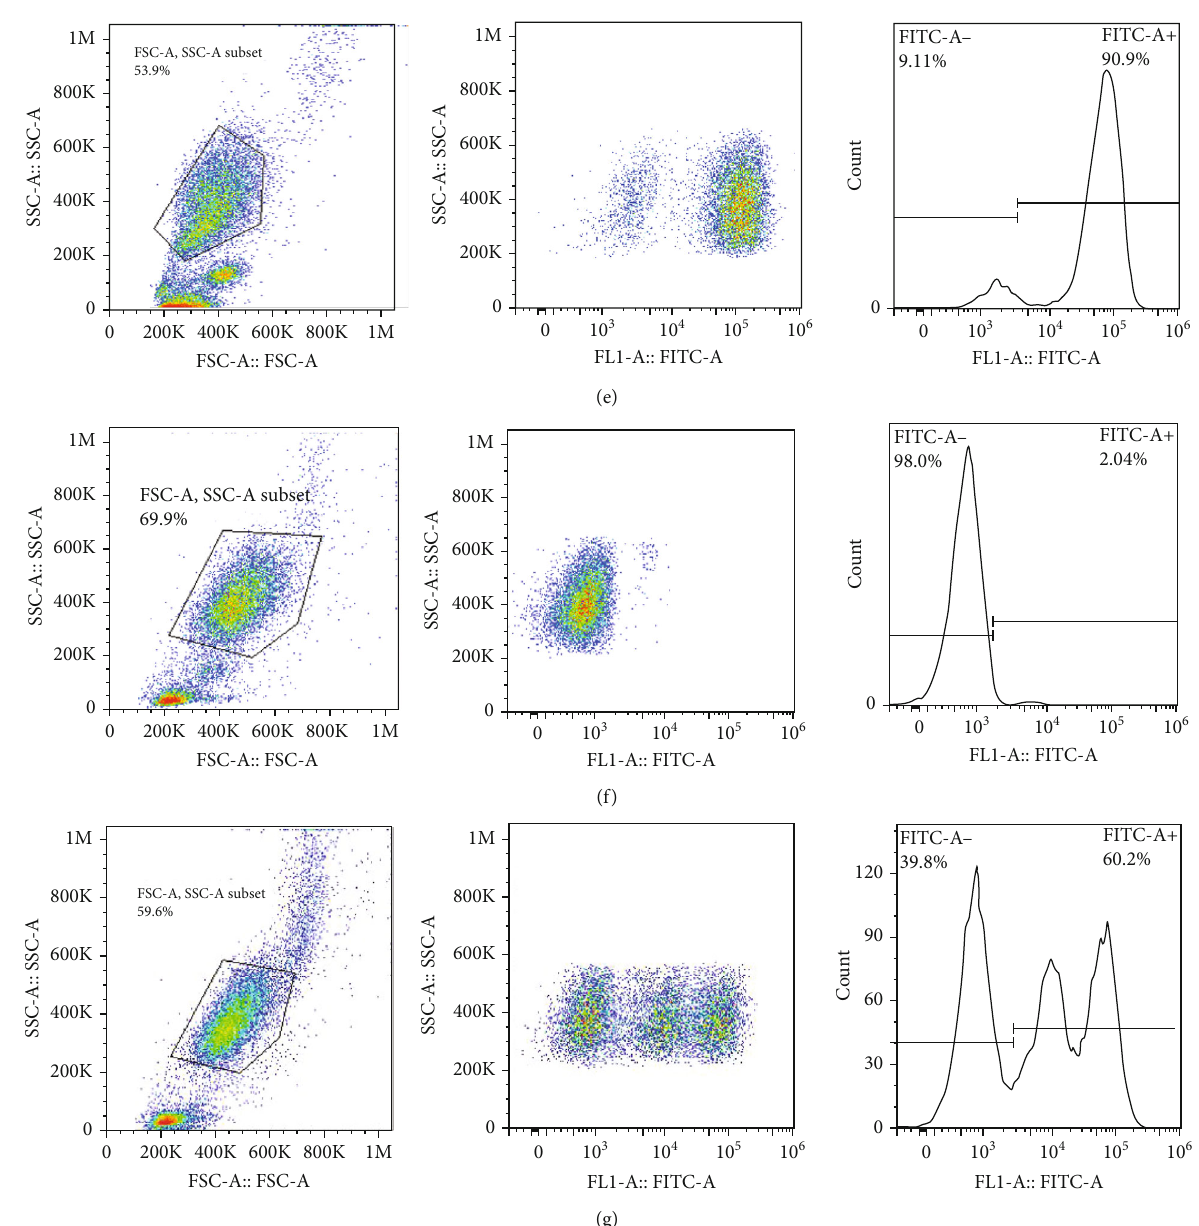
Figure 2: Flow cytometry analysis of HNA-2 expression on the neutrophils. The neutrophils were stained in whole blood with FITC conjugated anti-CD177 antibody. (a, b) Unstained and isotype controls were used to set up the fl ow cytometer and analyze the results. Based on HNA-2 expression, two distinct populations were identi fi ed. Among donors, the expression of the HNA-2 antigens was varied. For analysis, individuals were divided into four categories: (c) HNA-2 expression between 5% and 50%, (d) HNA-2 expression between 50% and 60%, (e) HNA-2 expression more than 60%, and (f) with the HNA-2 expression less than 5% (negative). (g) Individuals with two positive populations were analyzed as atypical expression of the HNA-2 antigen. In the histogram plots, CD177 positive and negative neutrophils were identi fi ed using bifurcated